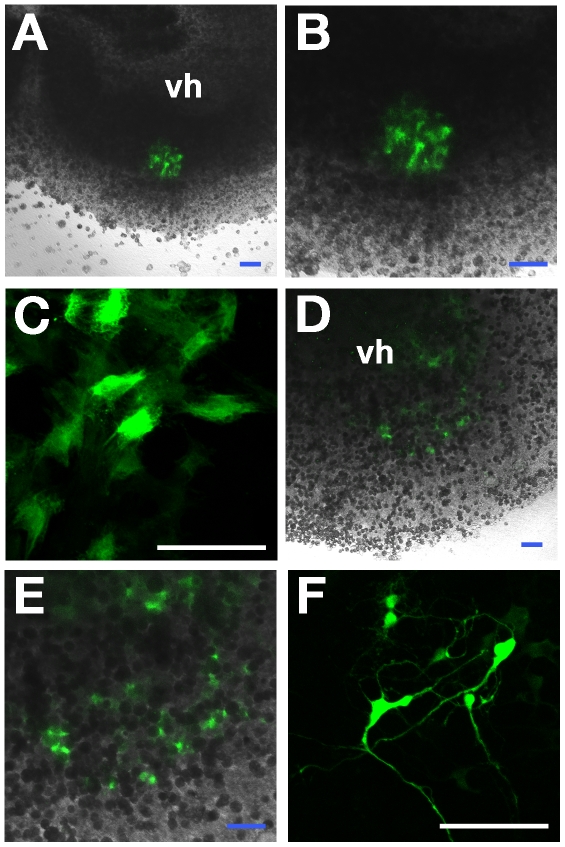

Ex vivo assessment of EOH cells or MNIM-EOH cells after transplantation into the spinal cord slice culture.Confocal images of uninduced EOH cells (green) (A-C) or MNIM-EOH cells (green) (D-F) at 2 days after transplantation into the ventral horn area (vh) of a spinal cord slice. (B) and (E) are a higher magnification of (A) and (D), respectively. (C) Confocal image of transplanted EOH cells with a flattened and symmetrical fibroblast-like morphology. (F) Confocal image of transplanted MNIM-EOH cells with a neuron-like morphology. Scale bars: 100 µm.